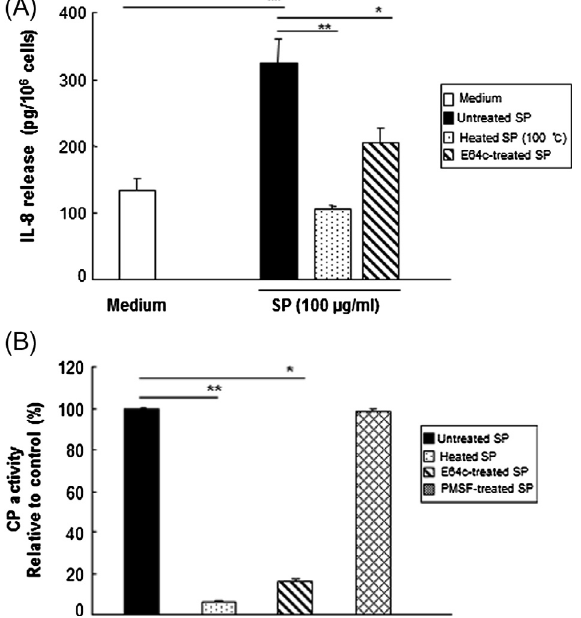
Figure 3. Amoebic cysteine protease activity is required for IL-8 production in HMC-1 cells induced by E. histolytica -derived secretory products (SPs). (A) IL-8 production in HMC-1 cells stimulated with SPs from native or modified wild-type SPs either heat-treated (100 (cid:3) C, 10 min) or treated with 25 l M protease inhibitor (E64c). ( n = 4) (B) CP activity from native or modified wild-type SPs with heat- (100 (cid:3) C, 10 min) or 25 l M protease inhibitor (E64c or PMSF) treatment were measured using z-Arg- Arg-pNA Æ 2 HCl as a substrate. The level of activity is shown as a percentage relative to the control. ( n = 3). All reactions were performed in triplicate measurements of each experiment. Data are presented as the mean ± SEM of at least three independent experiments. The asterisks indicate the results of comparisons with the controls (* p < 0.05. ** p < 0.01). Figure 4. E. histolytica -derived secretory products (SPs) from the